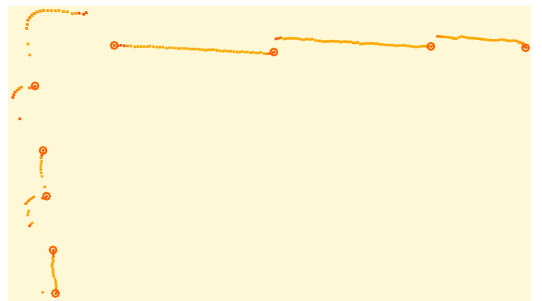
Figure 2. An example of 2D laser scan points for which the curvature is calculated. Dark orange points correspond to scan points with large curvature values while light orange points indicate a small curvature value. Circled points are extracted as edge points. Since too many planar points were extracted they are not depicted in this figure.